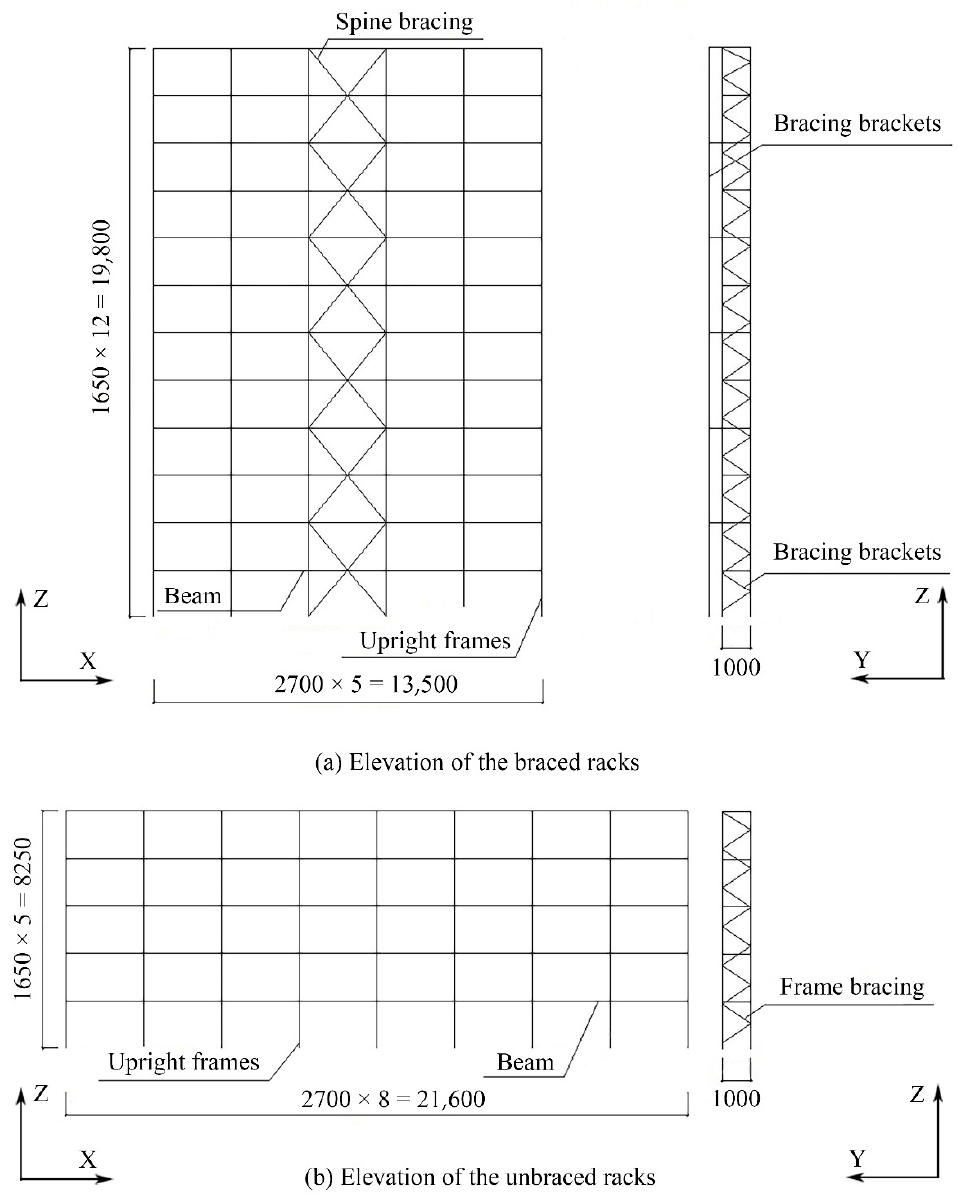
Figure 2. Detailed dimensions of the components (units: mm).